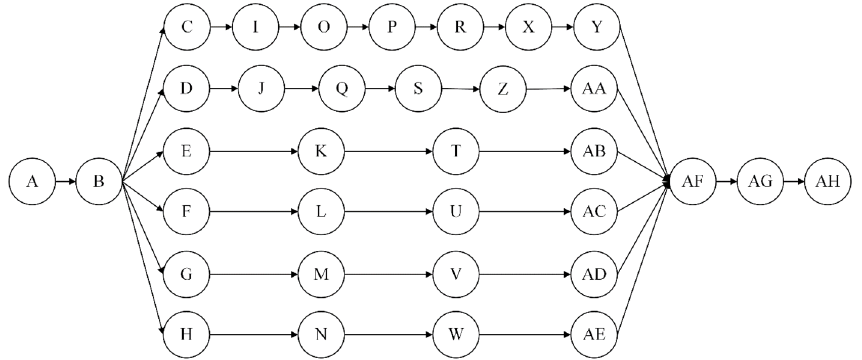
Figure 4. Project working procedure.